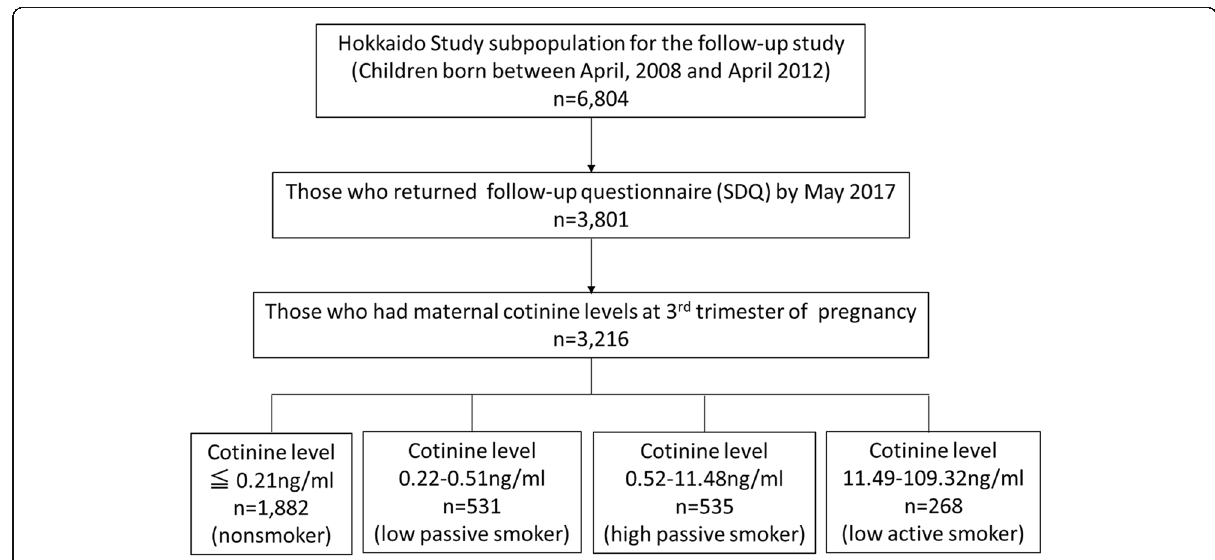
Fig. 1 Selection of study population. Among children born between April 2008 and April 2012 ( n = 6804), 3081 returned follow-up questionnaires by May 2017. Among 3801, maternal cotinine levels at the third trimester was available for 3216. These 3216 were categorized into four groups based on the maternal cotinine